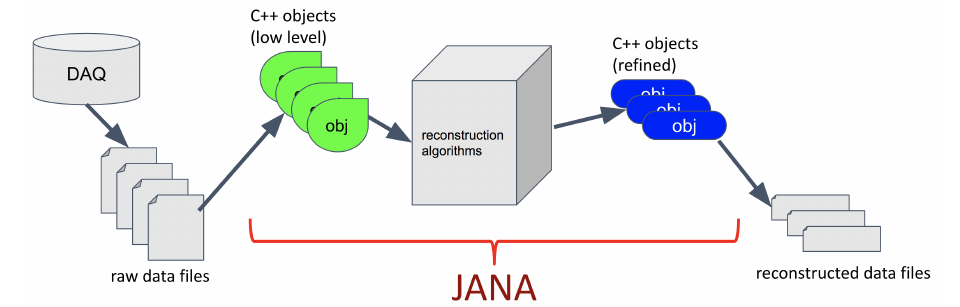
Figure 1. Diagram of where JANA fits in a traditional triggered DAQ system where data is recorded first to files and then replayed later to produce high level reconstructed objects. JANA’s core purpose is to organize algorithms and e ffi ciently apply them to low-level data objects in order to produce higher level ones.